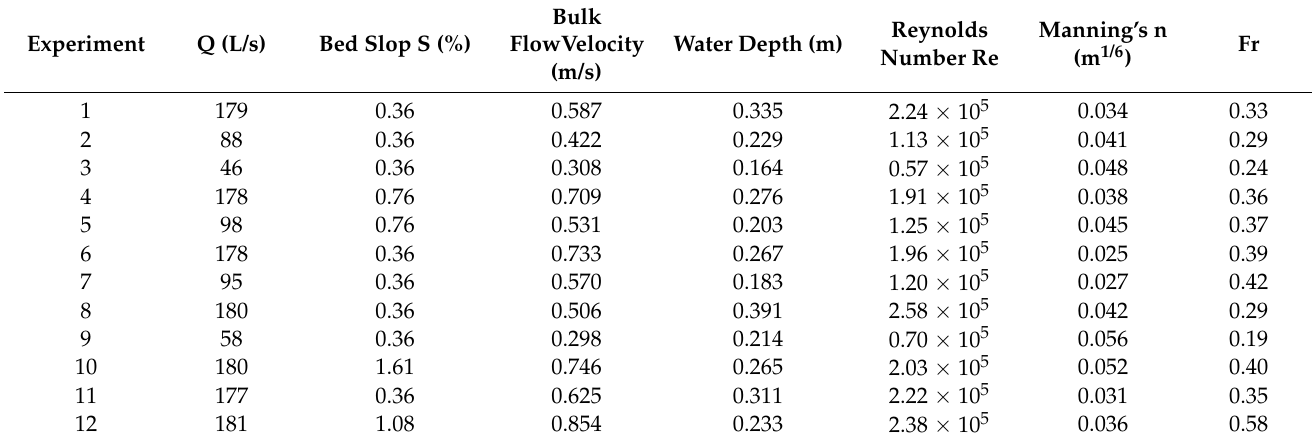
Table 2. Main flow features of the experiments in Dunn et al.